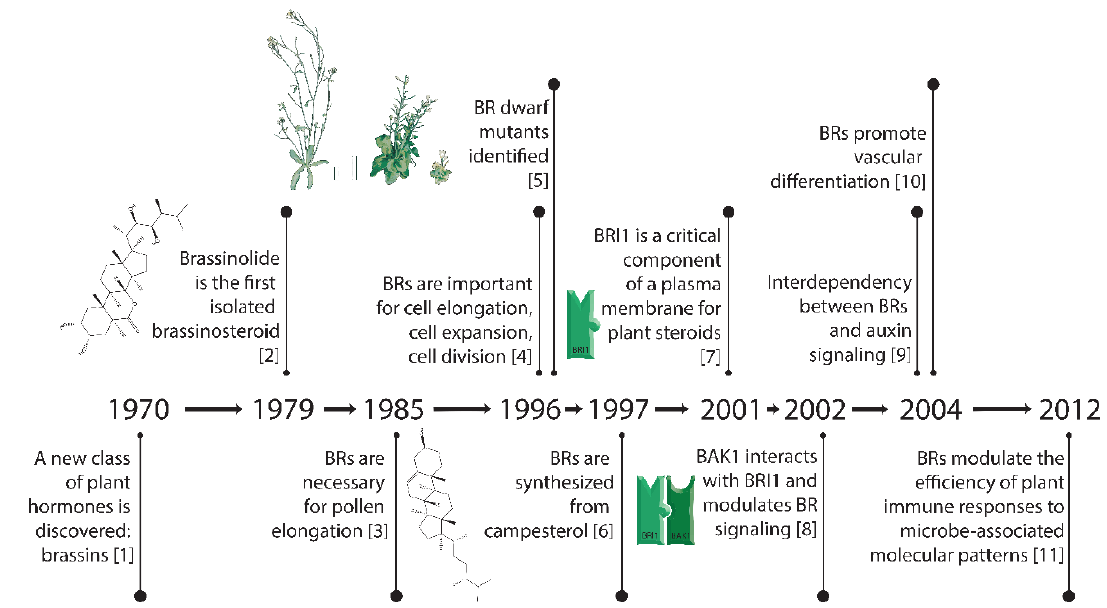
Figure 1. Key breakthroughs in the timeline of research on brassinosteroids. [1–11]